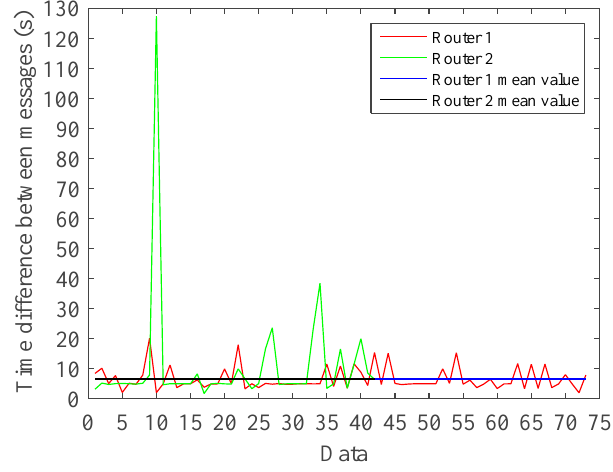
Figure 19. Case A.5: Time intervals between the data points received.